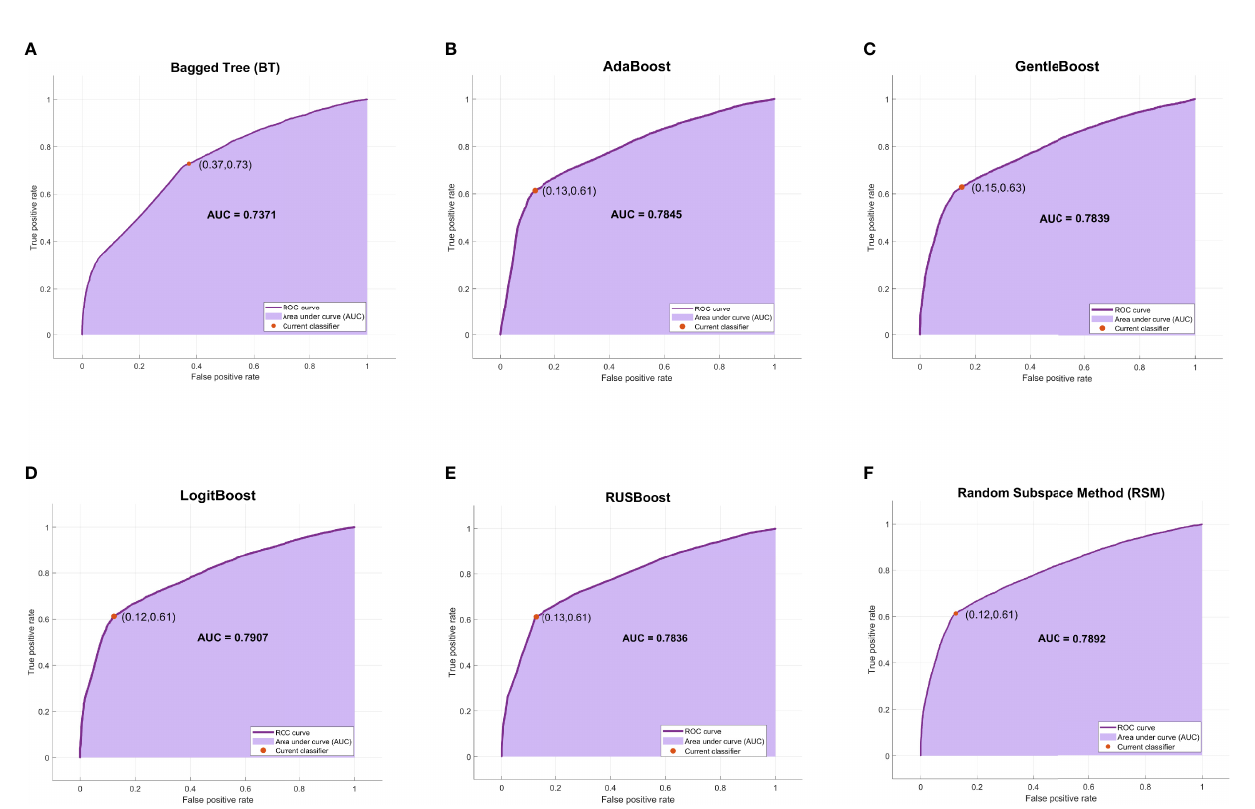
FIGURE 4 | The ROC curves and AUC scores of six ensemble learning models. (A) The ROC curve and AUC score of BT model: the deep purple curve refers to the ROC curve, the area under the curve is covered by light purple color, the orange dot represents the threshold that corresponds to the optimal operating point, and the AUC score is clearly marked. (B – F) The ROC curve and AUC score of AdaBoost, GentleBoost, LogitBoost, RUSBoost, and RSM, respectively. ROC, receiver operating characteristic; AUC, area under the receiver operating characteristic curve; BT, bagged tree; RSM, random subspace